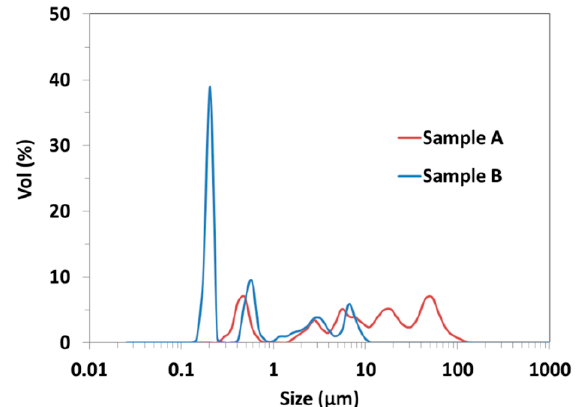
Figure 2. Scanning electron microscopy (SEM) images of the polishing waste samples: ( a ) sample A shows the coarser particles and ( b ) sample B shows the finer particles. Sample A is from plate glass polishing and sample B is from mirror polishing.